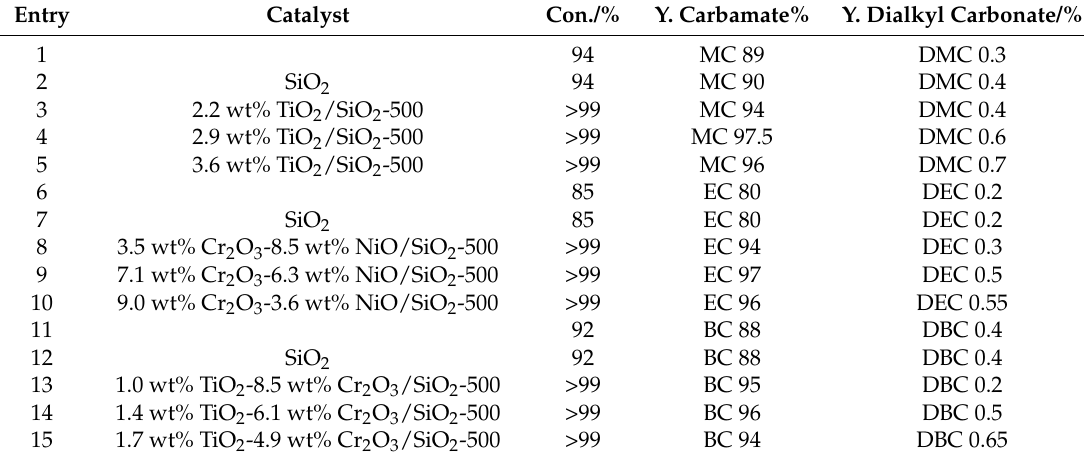
Table 2. Effect of catalyst loading on synthesis of alkyl carbamate